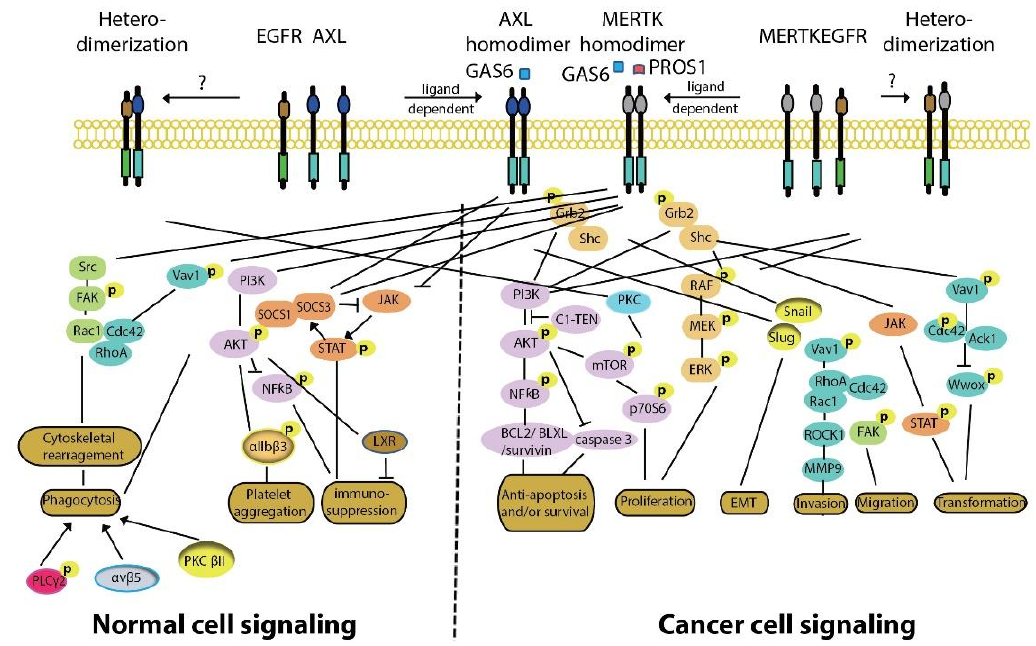
Figure 2. MERTK and AXL signaling in normal and cancer cells. MERTK and AXL play important physiological roles in phagocytosis, platelet aggregation, and immune suppression. Abnormally expressed MERTK and/AXL on NSCLC and other cancer cells are involved in tumorigenesis, including promoting tumor cell survival and proliferation and tumor cell invasion and metastasis. Besides, cross talk between AXL and EGFR, MERTK and EGFR, and AXL and MERTK have also been implicated in drug resistance in the treatment of